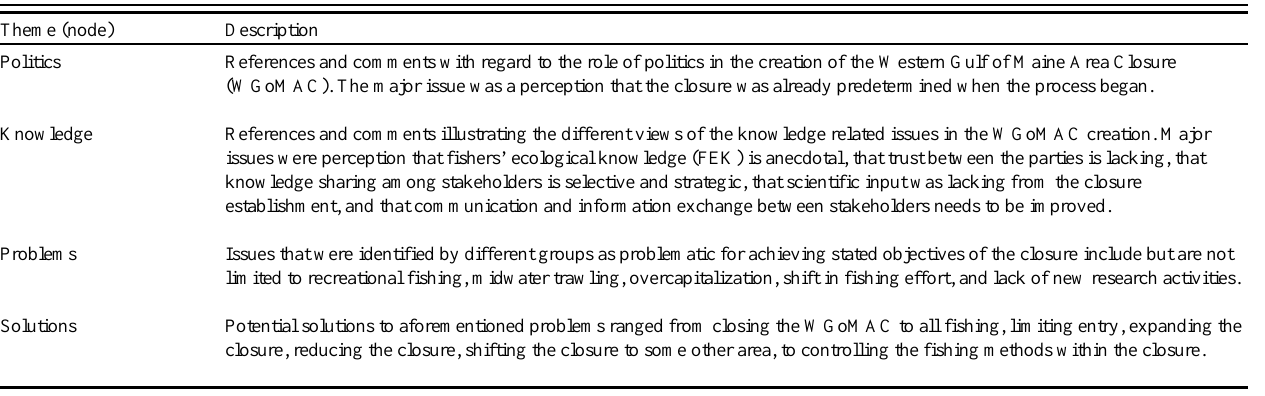
Table 2 . Coding structure: major themes that were identified during the qualitative data analysis. These guidelines were used in Table 4. Not all themes were discussed in this